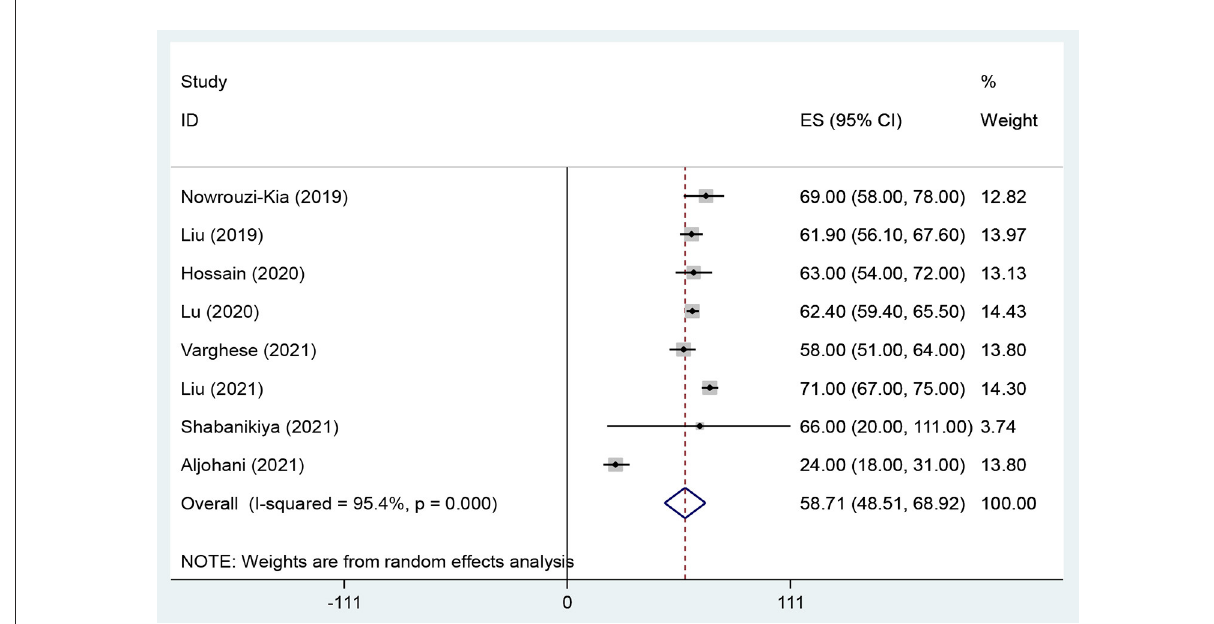
FIGURE2 The Forest plot of overall and individual prevalence of WPV with 95% confidence interval.